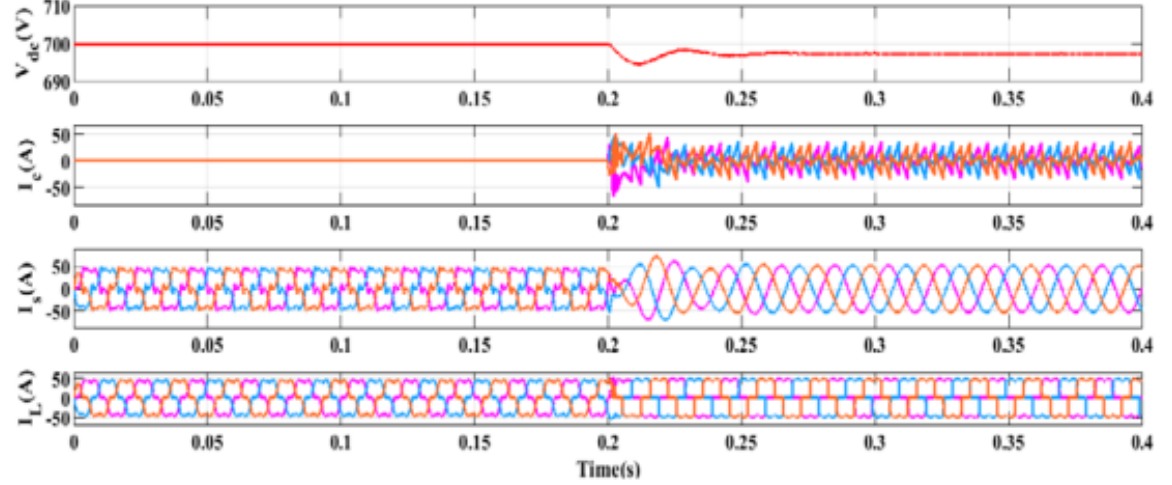
Figure 17. Performance of enhanced SRF SOGI-FLL control DSTATCOM under voltage-source non-linear load.